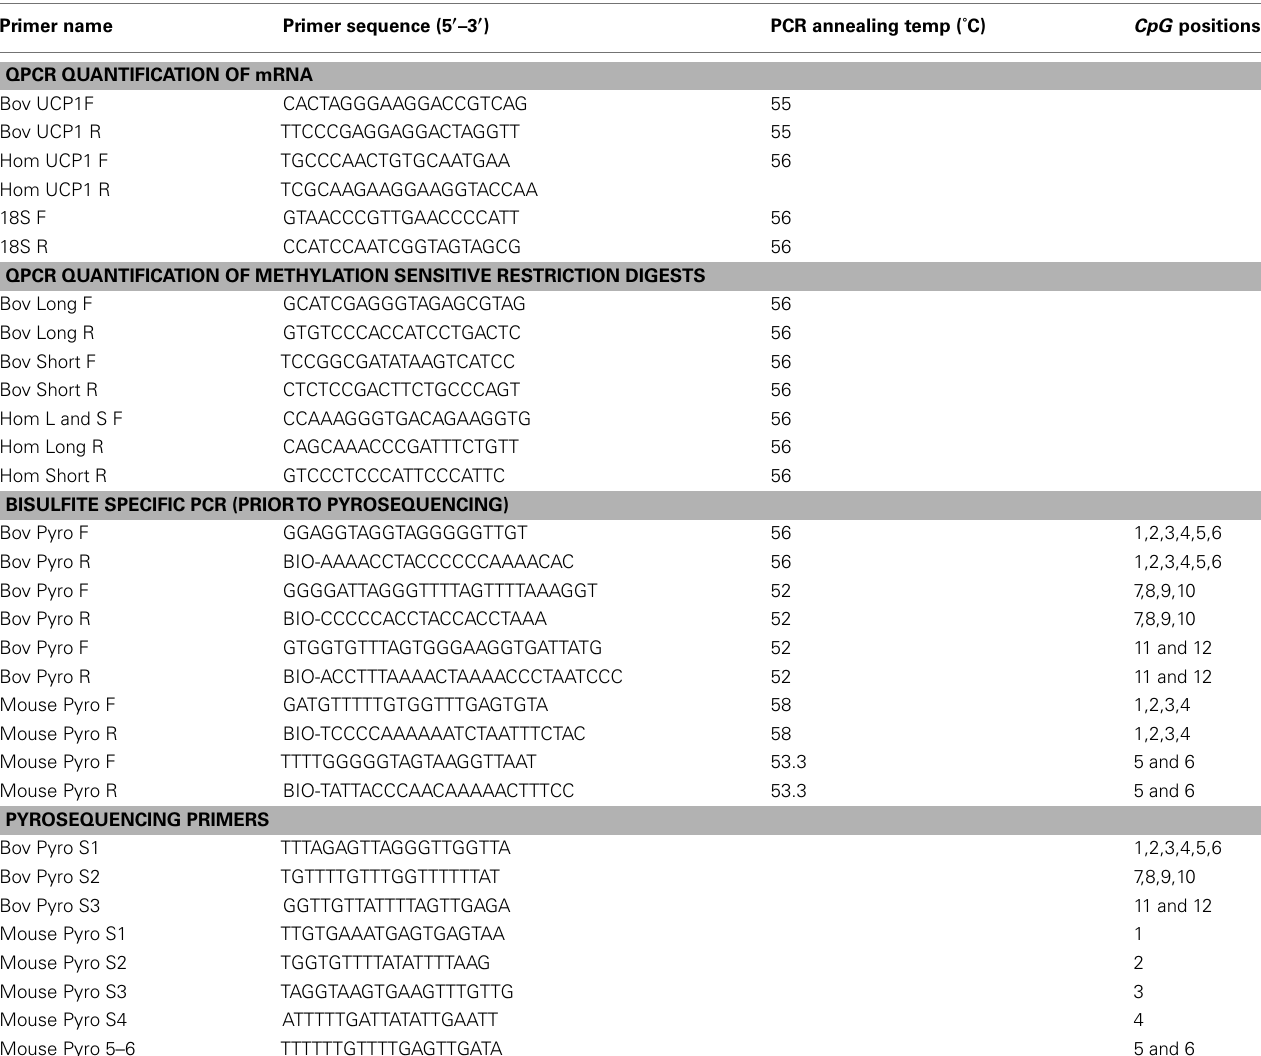
TableA3 | Primer sequences for QPCR quantification of mRNA and methylation sensitive restriction digests, bisulfite specific PCR, and